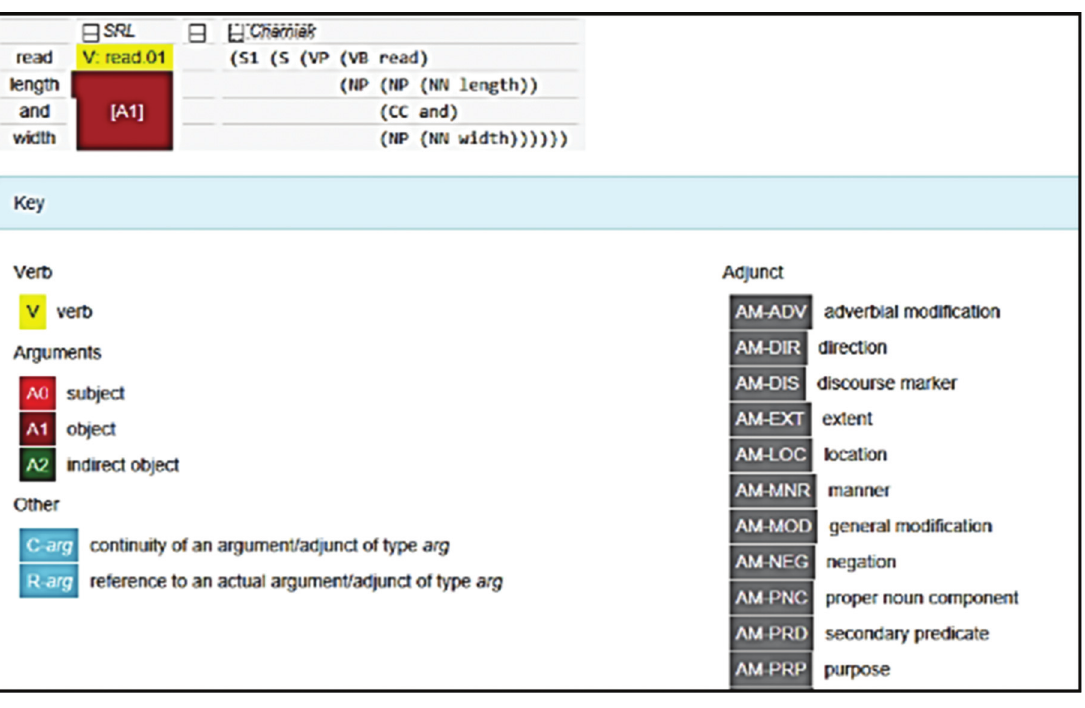
Figure 5: Linguistic Analysis Resulting from SRL Demo [41].